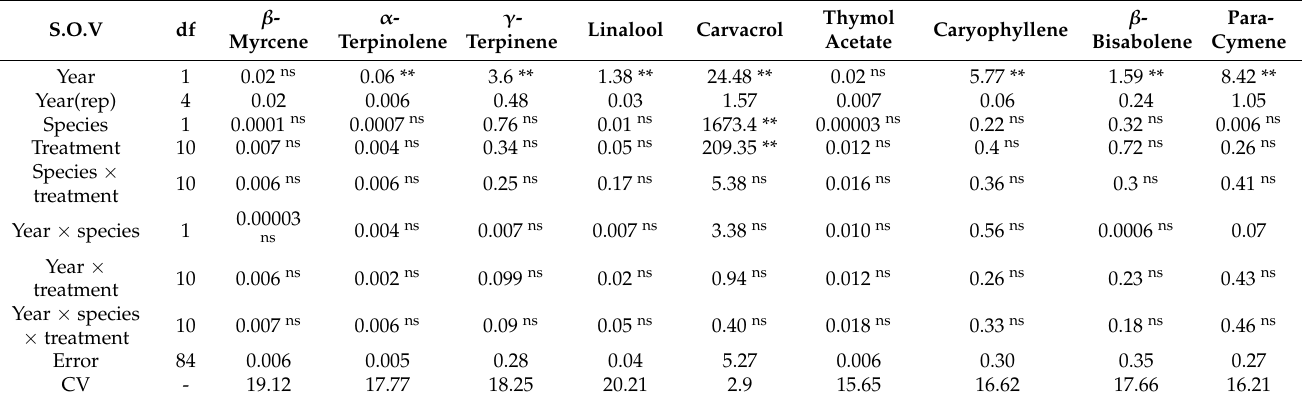
Table 4. Summary of combined analysis of variance of essential oil compositions of